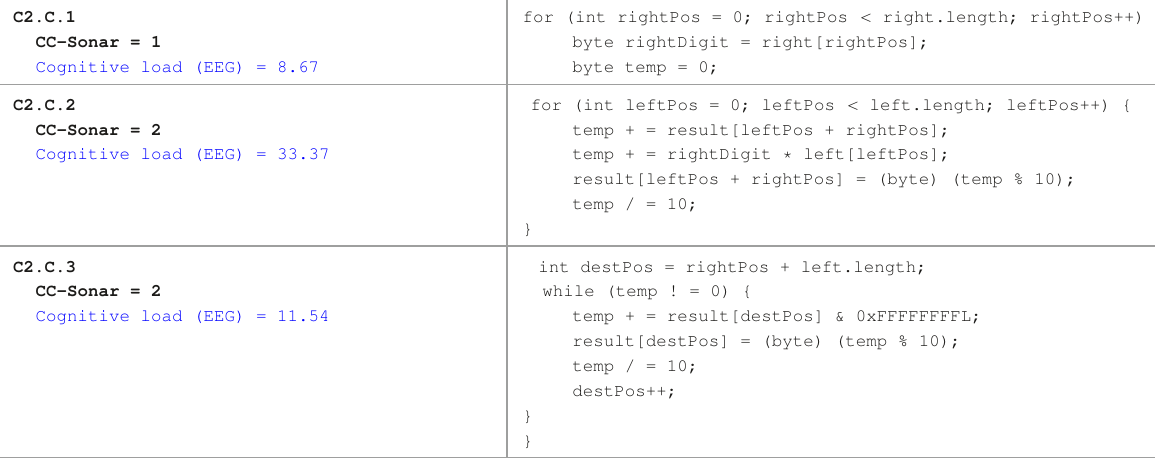
TABLE 11 Examples of code regions with relatively high CC-Sonar and very low cognitive load